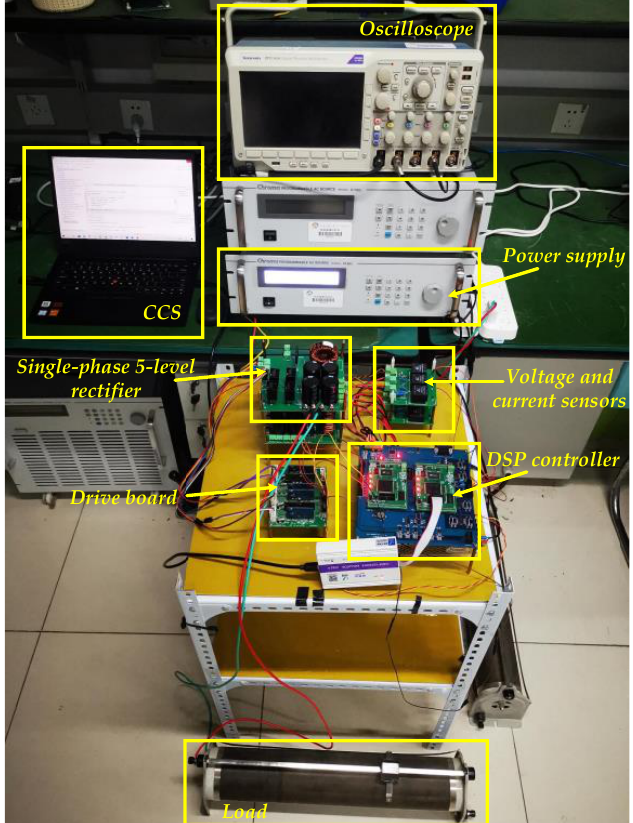
Figure 12. The prototype of single - phase five - level rectifier.